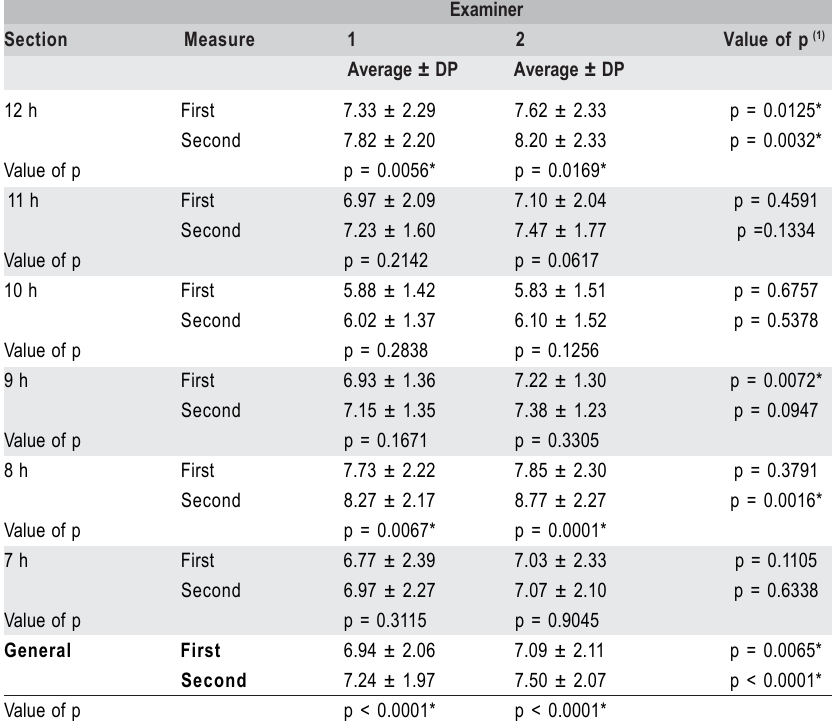
Table 4. Measurements in millimeters and standard deviation of the width of the right peri-orbital bone according to the measurement site, measurement, and examiner.